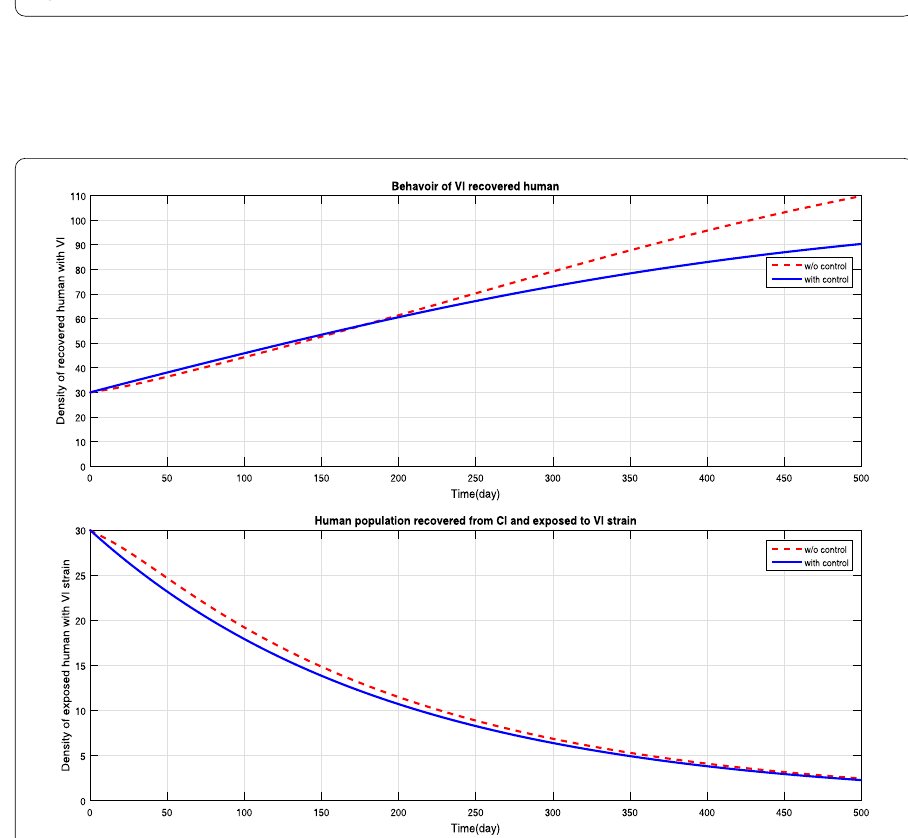
Figure 6 Comparison of behaviors with and without control in case of R 2 and E